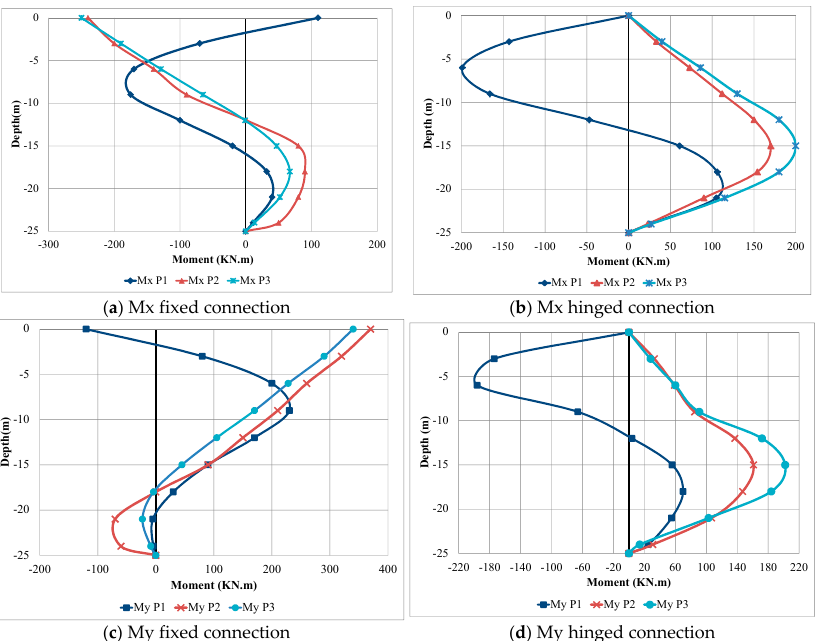
Figure 8. Bending moments along the selected piles P1, P2, and P3 assuming fixed and hinged pile-platform connections.